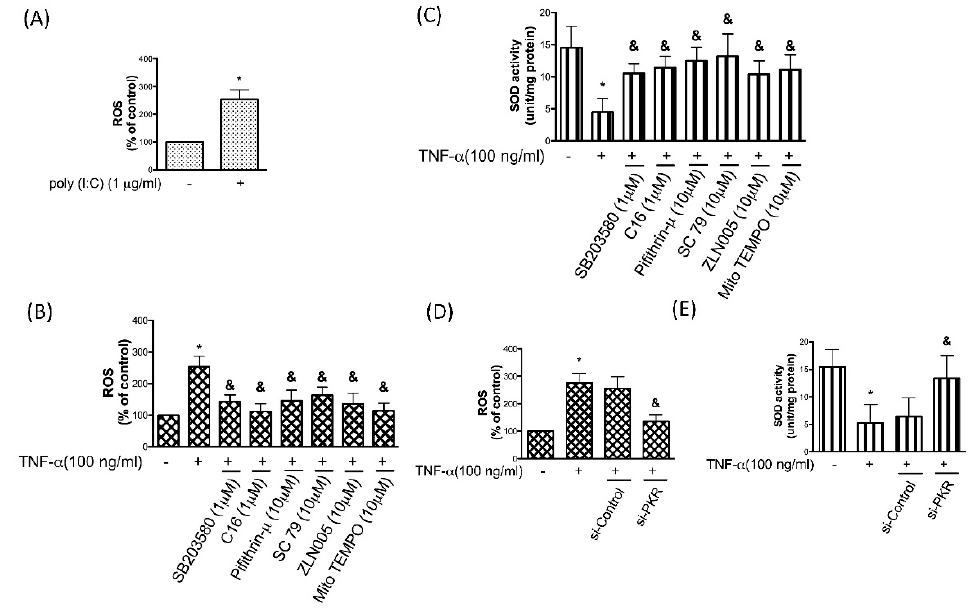
Figure 6. ROS production was elevated in chondrocytes treated with poly (I:C). ( A , B ) ROS generation and ( C ) SOD activity were determined in the TNF- α -stimulated chondrocytes with p38 inhibitor SB203580, PKR inhibitor C16, p53 inhibitor Pifithrin- μ , AKT activator SC79, PGC-1 α stimulator ZLN005, or a specific scavenger of mitochondrial superoxide Mito TEMPO. ( D ) TNF- α -induced ROS production and ( E ) TNF- α -inhibited ROS in chondrocytes were interfered by si-PKR. n = 3; * p < 0.05 compared to control group. p < 0.05 compared to TNF- α group, p values were generated by ANOVA using the Tukey’s test.